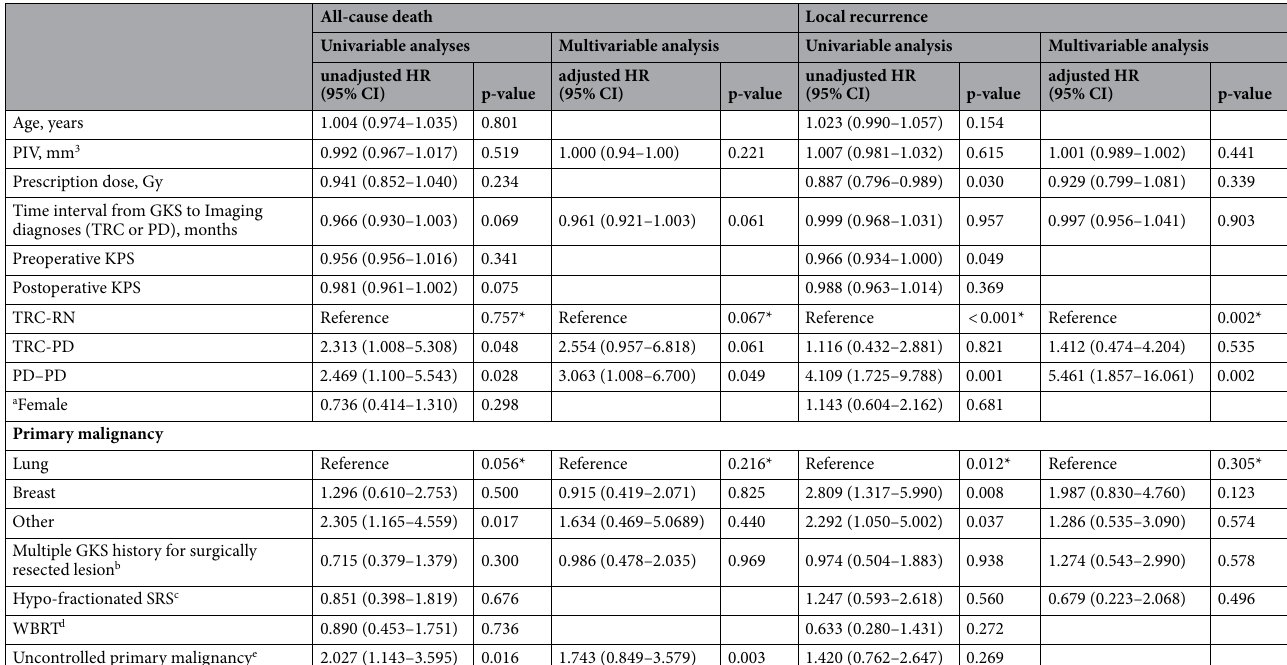
Table 3. Cox regression analyses for the risk of death and tumor recurrence. *The overall p-value of categorical data with more than two variables. a Reference was male. b Reference was no previous GKS for resected lesion. c Reference was a single session GKS. d Reference was no history of WBRT. e Reference was controlled primary